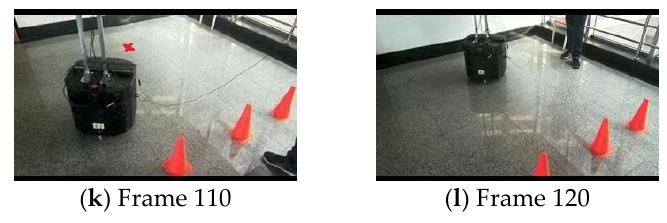
Figure 9. Result of robot experience.